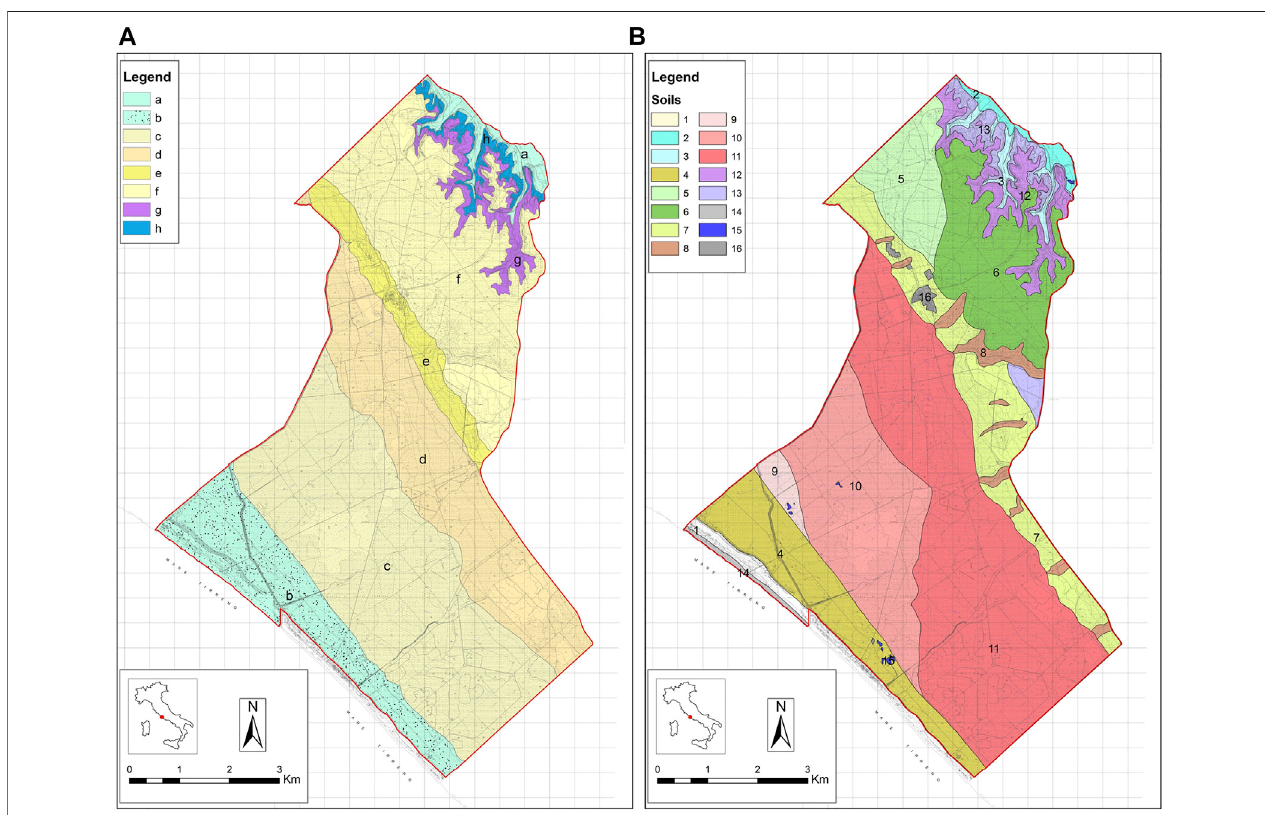
FIGURE 1 | (A) Sediment outcropping in the study area: Holocene deposits of alluvial (a) or coastal (b) origin; Pleistocene sands (c – f), volcanic deposits of the Colli Albani Volcanic sequence (g); and transitional and continental deposits (h) (mod. from Servizio Geologico d ’ Italia, 2009). (B) Map of soil distribution: soil of actual sandy deposits (1); soils of alluvial deposits (2 – 3); soil of recent sandy deposits (4); soils of coastal terraced area (5 – 6); soils of terrace scarp (7 – 8); soils of coastal plain (9 – 11); soil of volcanic deposits (12); soil of deltaic deposits (13); and soils of mixed areas (14 – 16) (mod. from Biondi et al., 2001).